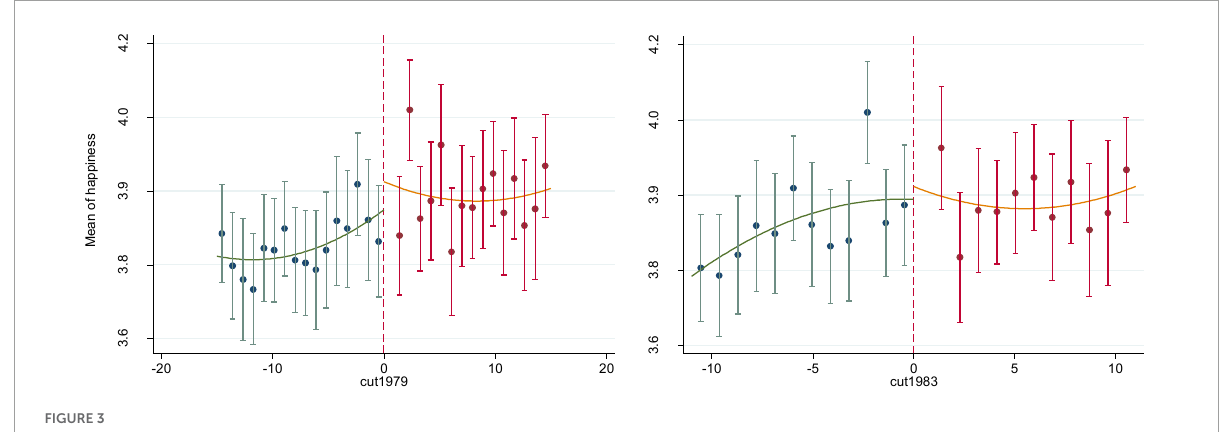
FIGURE3 Pseudo cut-off point tests using 1979 and 1983 as cut-off points.